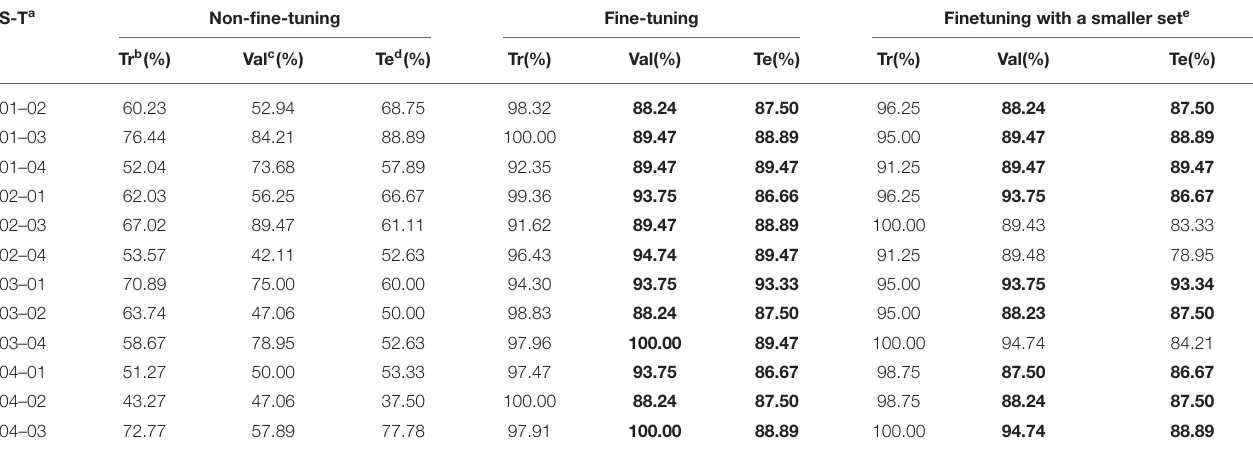
TABLE 3 | Classification results without and with fine-tuning. S-T a Non-fine-tuning Fine-tuning Finetuning with a smaller set e